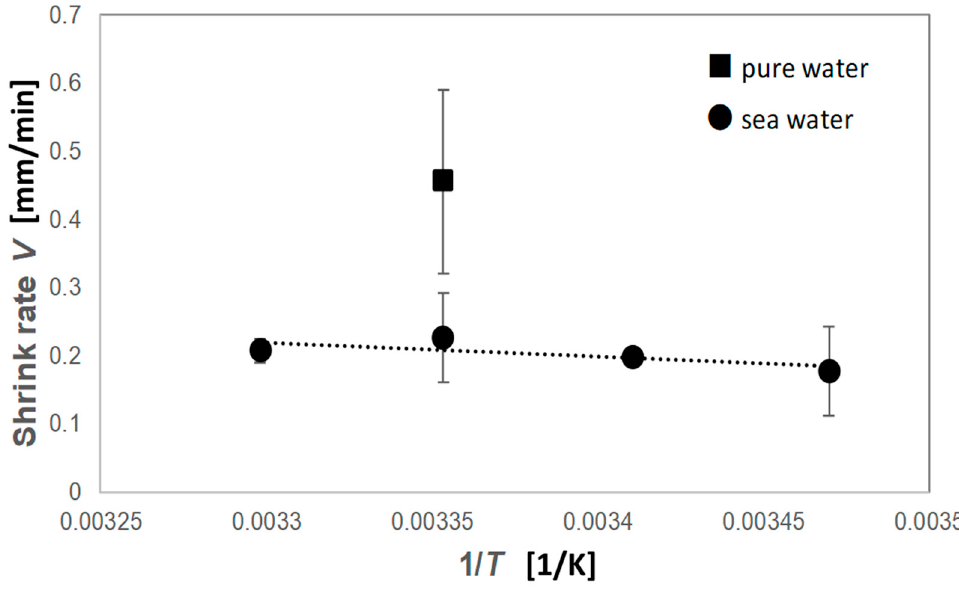
Figure 4. Temperature dependence of dissolution rate.